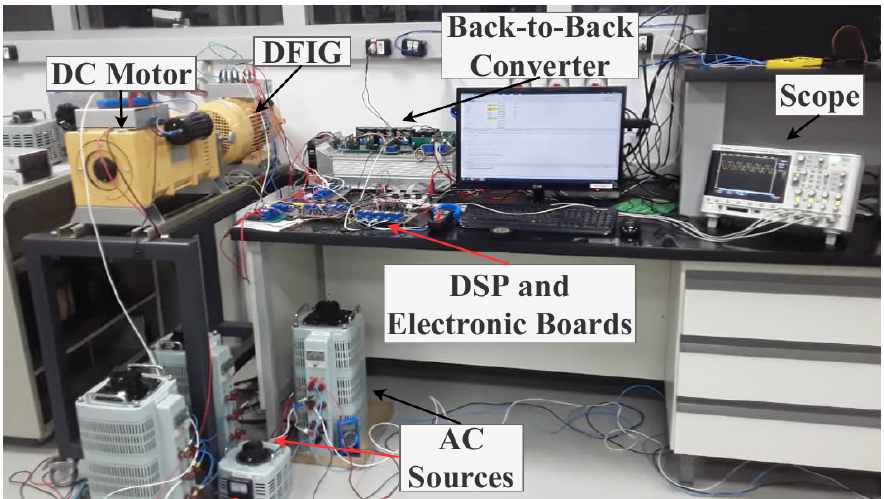
Figure 4. Experimental workstation